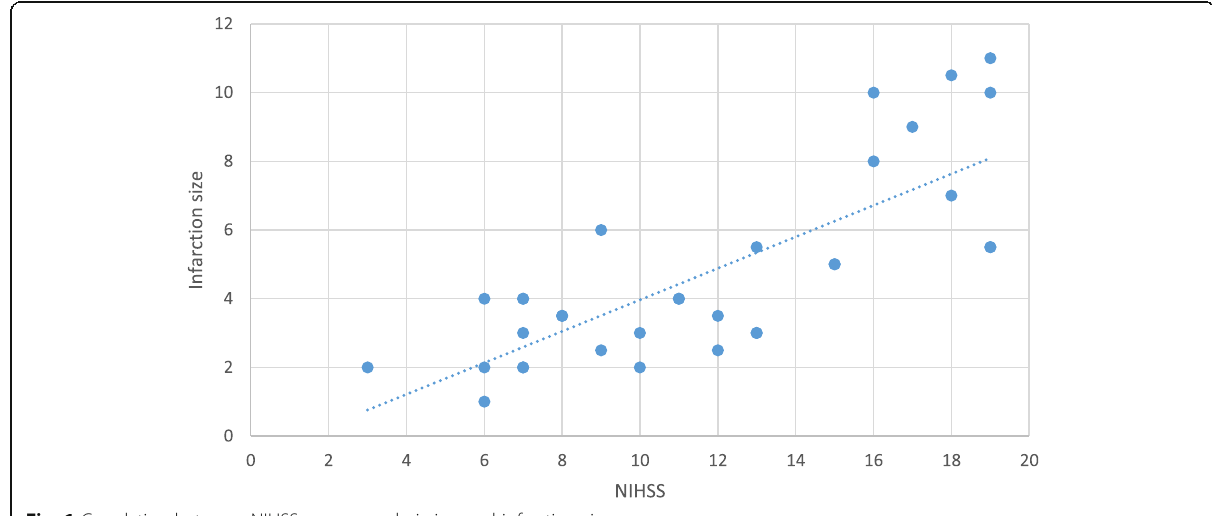
Fig. 1 Correlation between NIHSS score on admission and infarction size